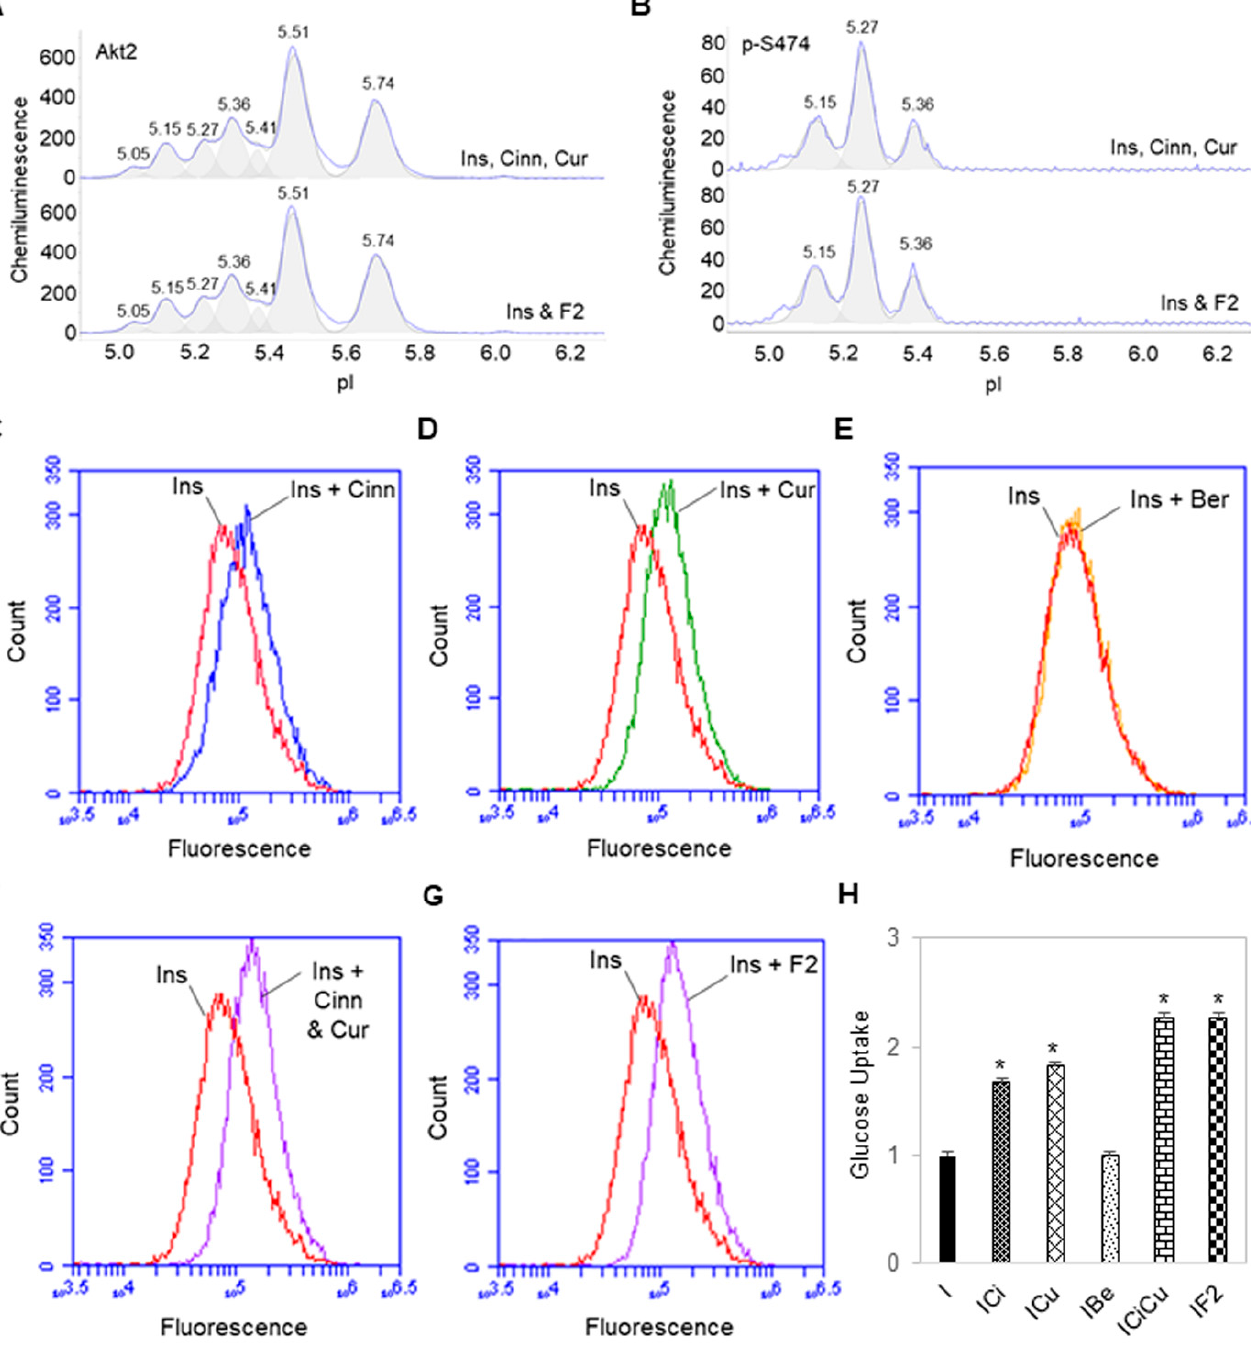
Figure 3. Additive effects of cinnamaldehyde and curcumin on Akt2 activation and glucose transport. ( A , B ) Distribution of Akt2 ( A ) and p-Akt2 (S474) ( B ) as a function of isoelectric points in preadipocytes treated with insulin (Ins), cinnamaldehyde (Cinn), and curcumin (Cur) (top electropherogram) or insulin, cinnamaldehyde, curcumin, and berberine (Ber) (bottom electropherogram). ( C – G ) 2-NBDG fluorescence in preadipocytes treated with insulin alone (red line) versus treated with ( C ) insulin and cinnamaldehyde (blue line), ( D ) insulin and curcumin (green line), ( E ) insulin and berberine (orange line), ( F ) insulin, cinnamaldehyde, and curcumin (purple line), or ( G ) insulin and F2 (cinnamaldehyde, curcumin, and berberine) (purple line). ( H ) relative abundance of 2-NBDG fluorescence in preadipocytes as a function of treatment condition. I, insulin; ICi, insulin and cinnamaldehyde; ICu, insulin and curcumin; IBe, insulin and berberine; ICiCu, insulin, cinnamaldehyde, and curcumin; IF2, insulin, cinnamaldehyde, curcumin, and berberine. Asterisk indicates p -value ≤ 0.01 versus treatment with insulin alone.